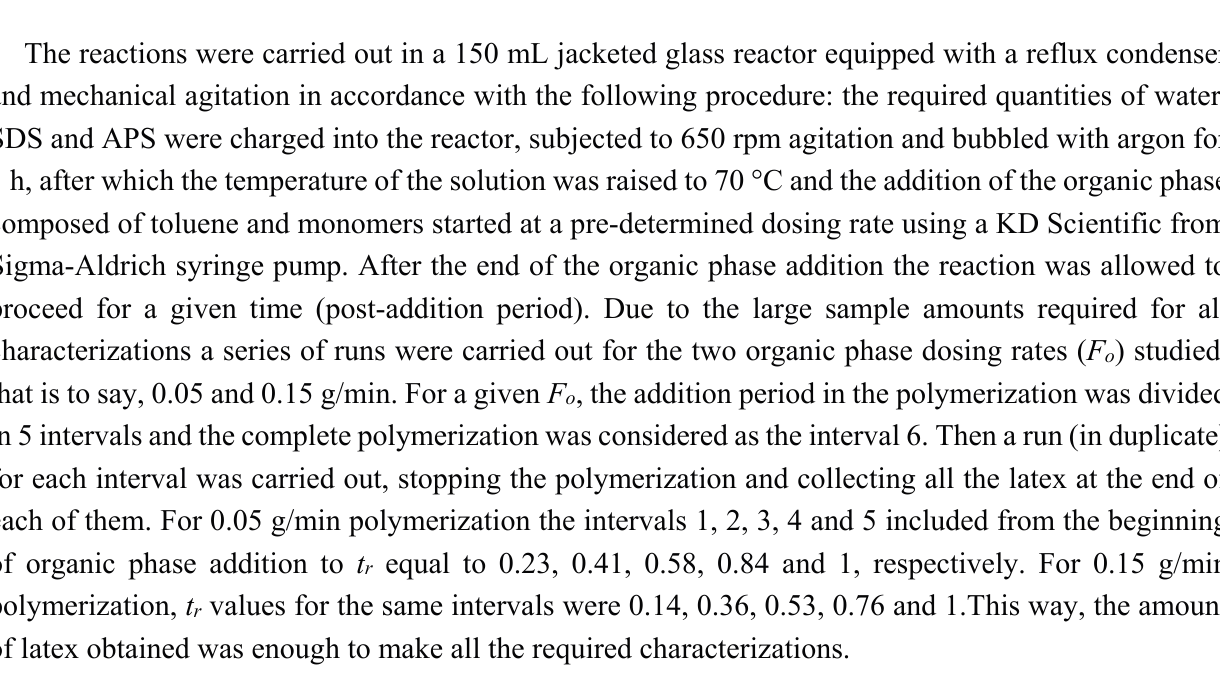
Table 4. Formulations used in the polymerizations at the organic-phase dosing rate of 0.05 g/min. M1 M2